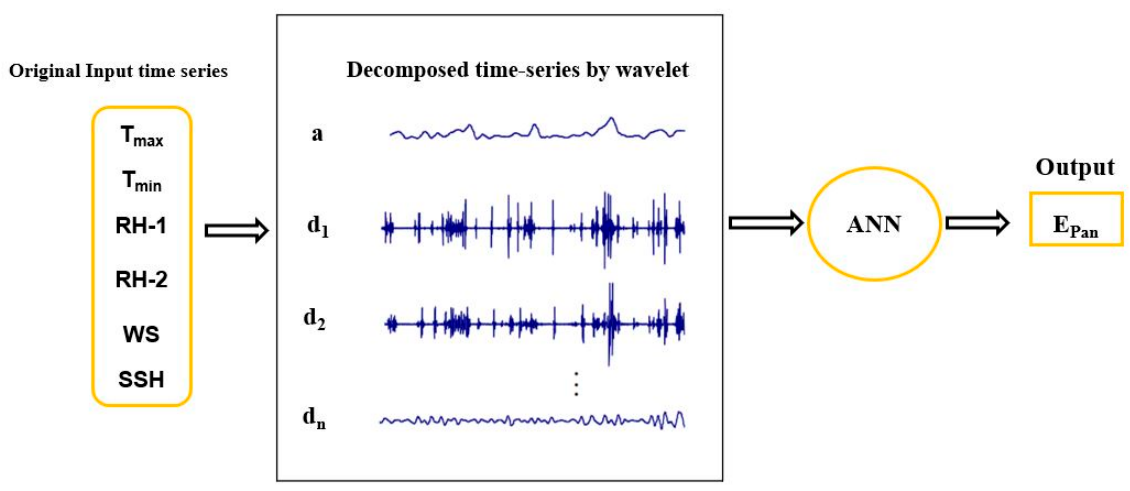
Figure 4. Schematic representation of WANN.